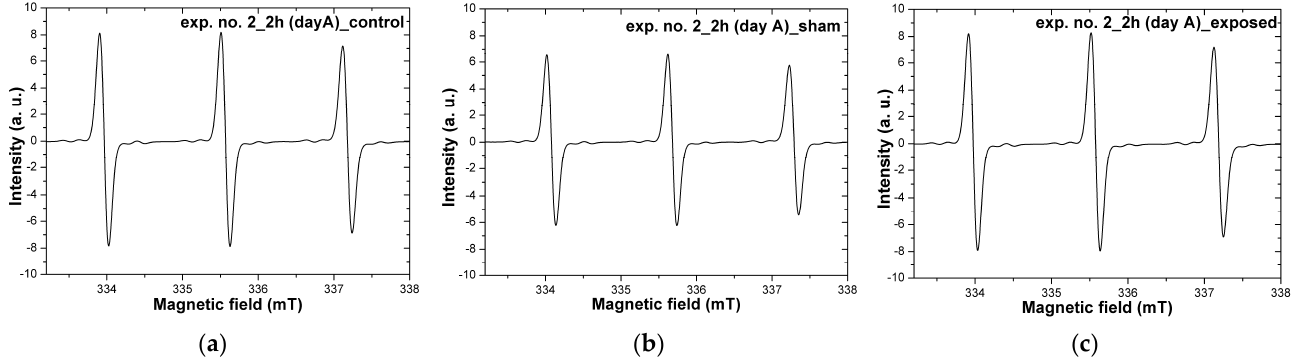
Figure 4. Representative EPR spectra of hMSC with CMH spin trap recorded at 2 °C: control sample ( a ), sham sample ( b ), and exposed sample ( c ).